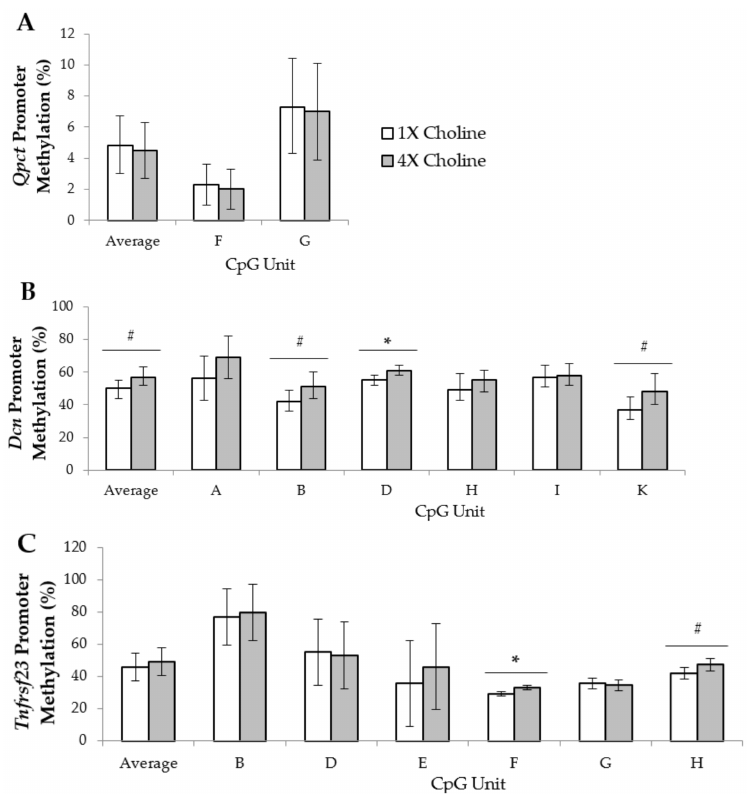
Figure 2. Average percentage of cytosine-phosphate-guanine (CpG) methylation across the promoter region and percentage of methylation of each CpG unit within the promoter regions of ( A ) Qpct ; ( B ) Dcn and ( C ) Tnfrsf23 in male placentas from dams in the 1X and 4X choline groups. Each CpG unit may contain more than one CpG site. Only CpG units with measurements that met the quality control criteria were included in the final analyses. One placenta (either male or female) from each dam ( n = 3 dams per treatment, per fetal sex) was used, and each placenta was considered to be a statistical unit in the statistical analysis. Data were analyzed using one-way ANOVA and are presented as means with 95% confidence intervals. * p ≤ 0.05. # 0.05 < p < 0.1.